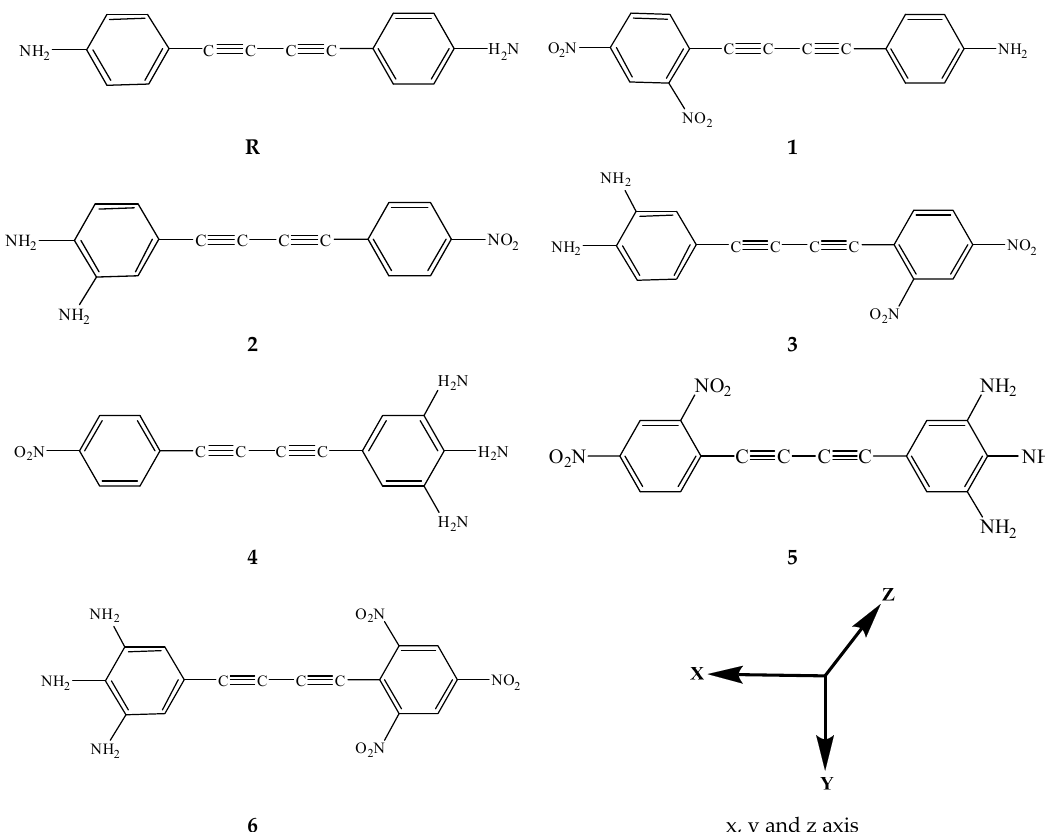
Figure 1. Representation of parent molecule R and designed compounds 1 – 6 .